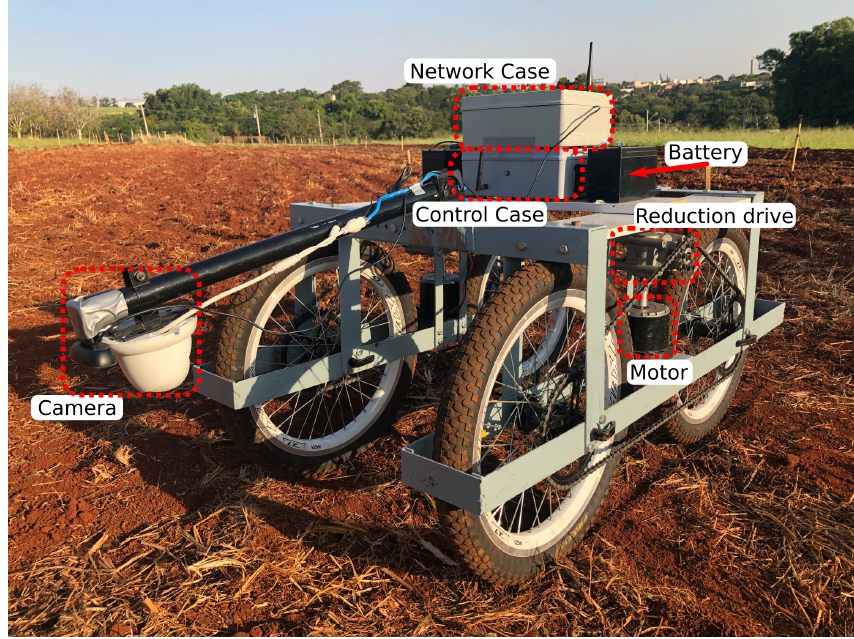
Figure 7. View of the DARob with its main